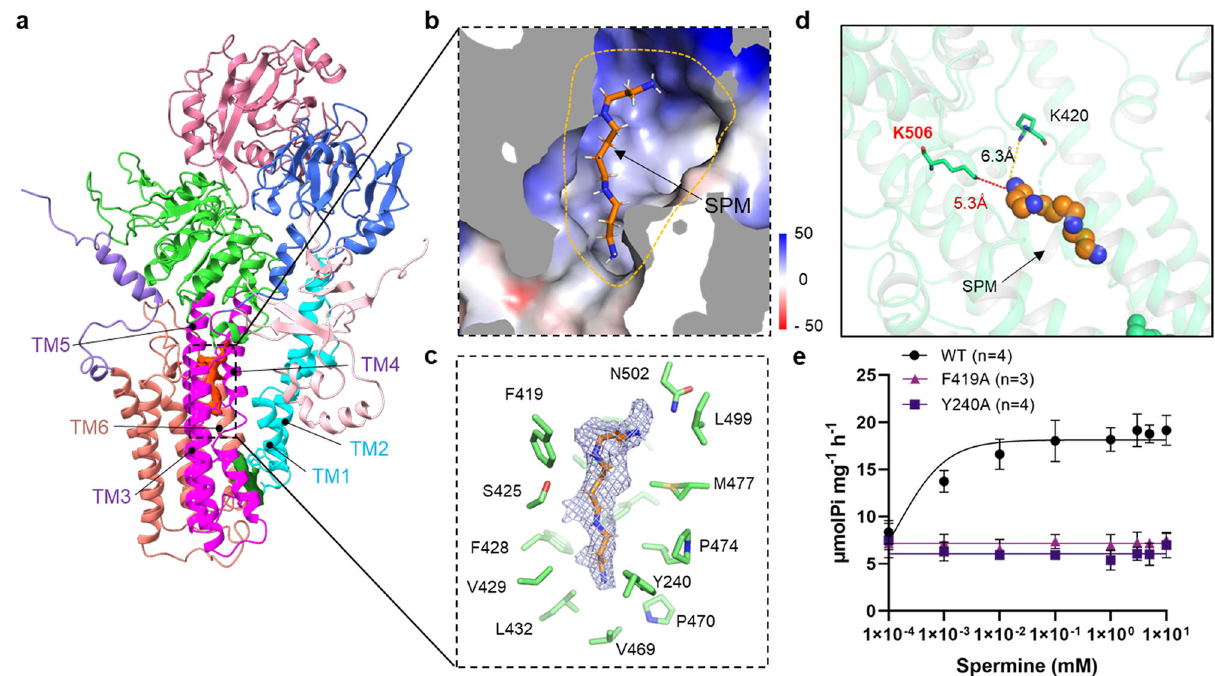
Fig. 3 | Structural analysis of hATP13A2 in E2-Pi state. a The overall structure of ATP13A2 in the E2-Pi state. The EM density of SPM is shown as ChimeraX ’ s “ solid ” (orange) representation at Site 2 . b Electrostatic potential surface of the inward- open cavity within the E2-Pi structure. TM2 and TM4b falling apart makes a large cavity. The SPM molecule is shown assticks. The yellow-dotted line represents the extent of the SPM binding pocket. c Representation of the SPM binding pocket of theE2-PiconformationatSite 2 .Thecryo-EMdensityfortheboundSPMisshownin